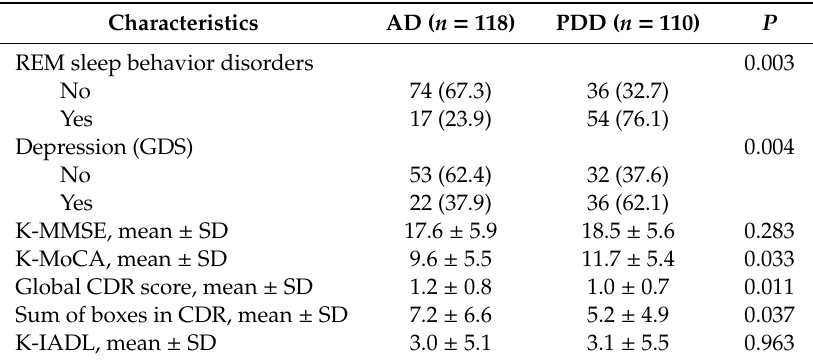
Table 2. Characteristics of Parkinson’s non-motor symptoms and neuropsychological tests by dementia type, independent T -test, n